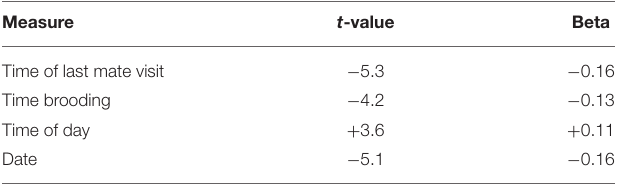
TABLE 3 | Results of linear regression analysis of factors affecting total interaction time. Measure